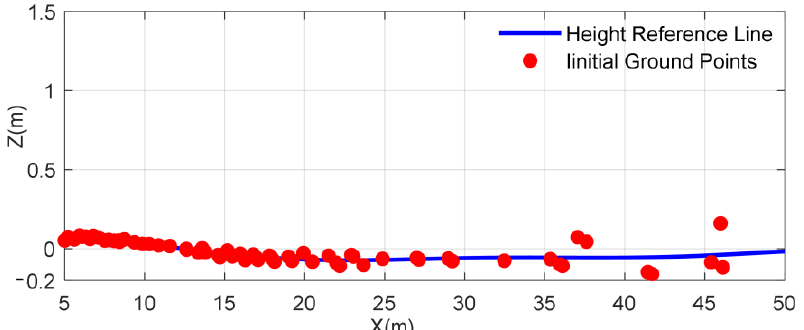
Figure 5. The results obtained by selecting six frame ground points and using the calculated parameters for Gaussian process regression.